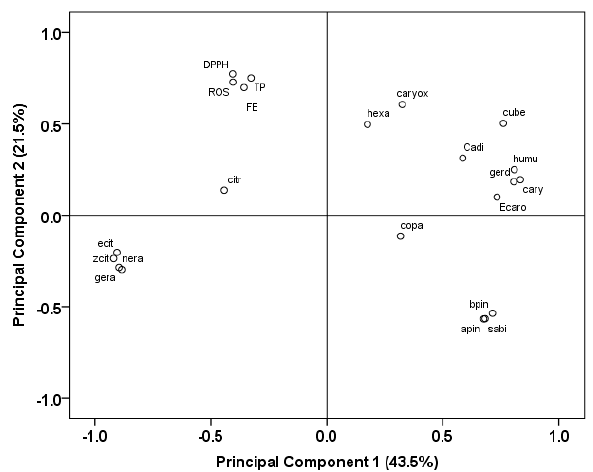
Figure 3. Loading of the leaf essential oil compounds, rosmarinic acid and antioxidant parameters on